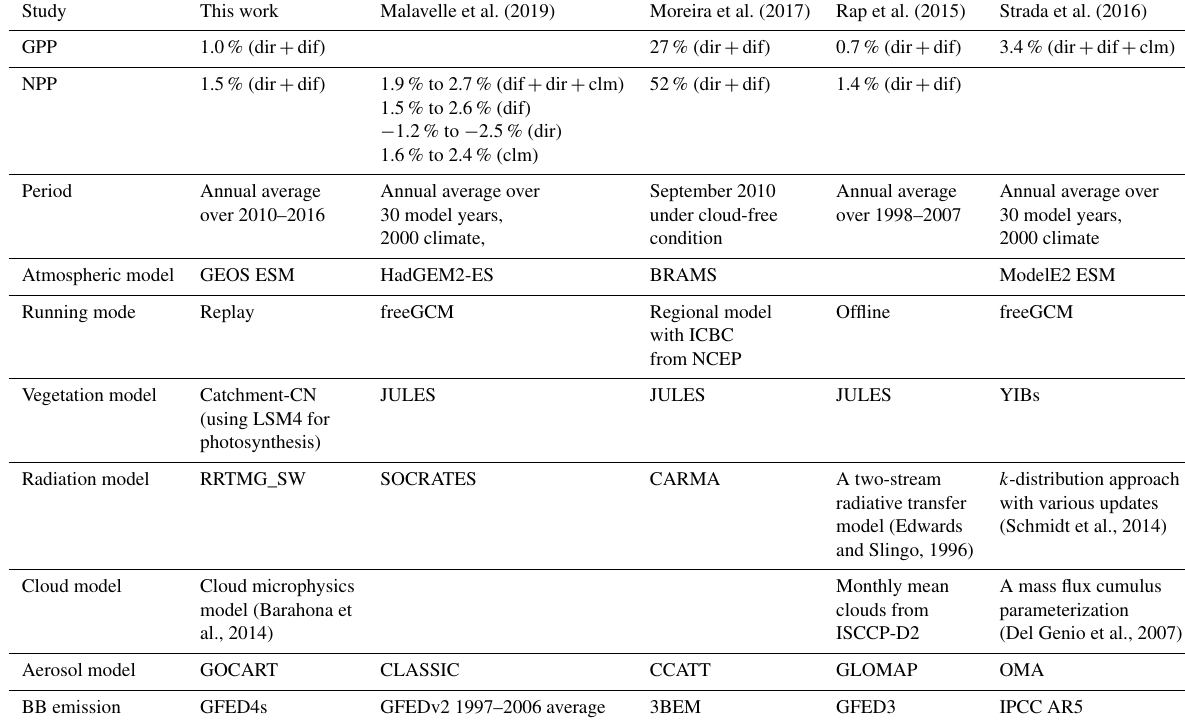
Table 2. Summary of model estimation of GPP increase in response to biomass burning aerosol over the Amazon Basin. Study This